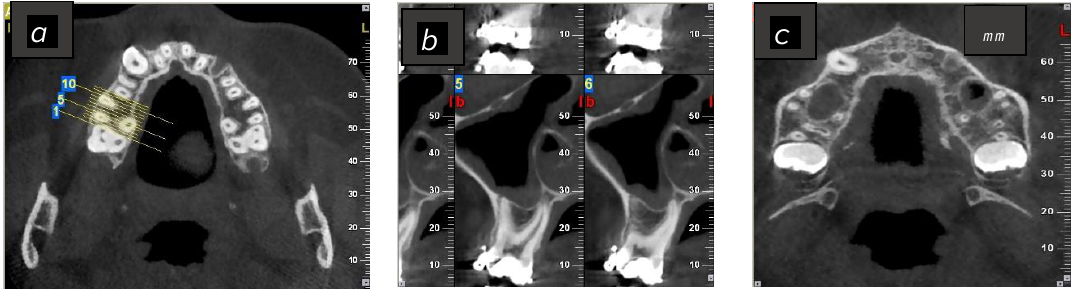
Figure 2. Representative CBCT images showing the palatal root apex in contact with the MSF. ( a , c ) A maxillary axial CBCT view; ( b ) a maxillary sagittal CBCT view. 1; 5 and 10 are the slices numbers.